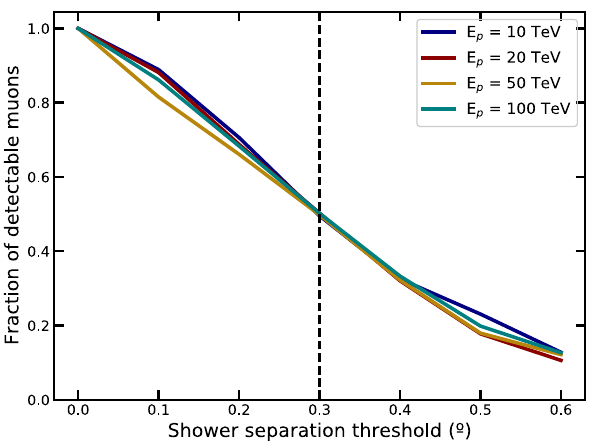
Fig. 5 Fraction of surviving muons as a function of the minimum shower separation threshold for several energies. Both the trigger and FoV criteria have already been applied. The dashed line indicates the chosen reference value of 0.3 ◦ which translates to roughly 50% survival due to this